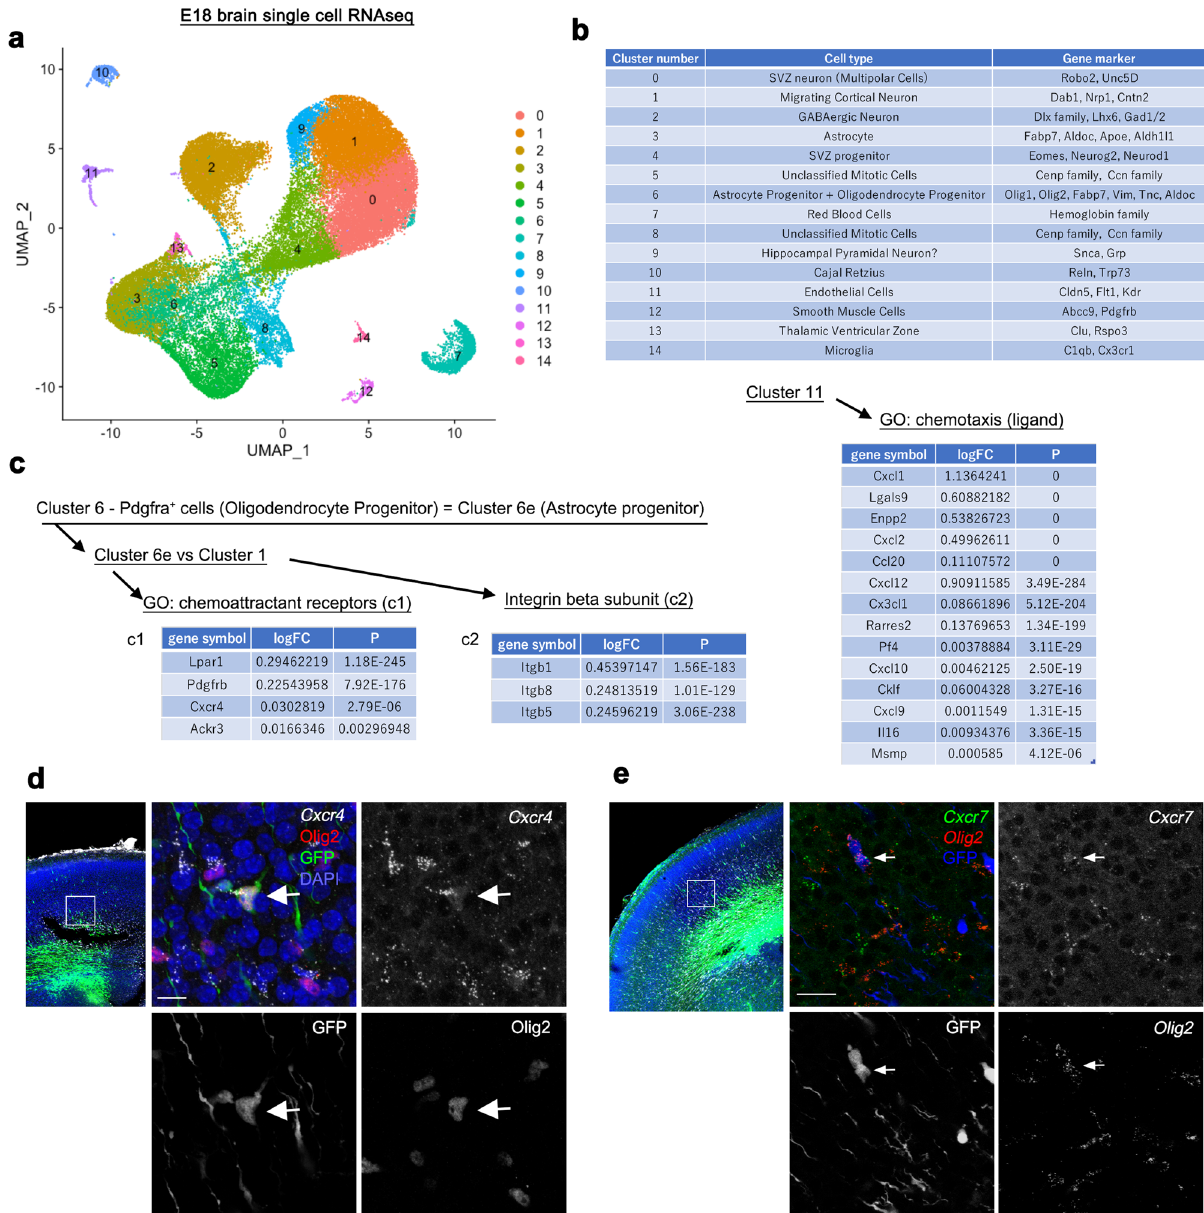
Fig. 5 | Identi fi cation of Cxcr4 and Cxcr7 (Ackr3) and Integrin β 1 as candidate molecules that regulate the blood vessel-guided migration. a UMAP (uniform manifold approximation and projection) visualization of approximately 50,000singlecellRNA-seqdatarandomlysampledfromthefulldataset(1.3million cells) of E18 mouse whole brains. 15 clusters were identi fi ed. b Annotation of cell types for the 15 clusters based on gene markers as indicated. Clusters 1, 6 and 11 represent migrating cortical neurons, glial progenitors (astrocyte progenitors and oligodendrocyte progenitors), and endothelial cells, respectively. c Identi fi cation of astrocyte-speci fi c chemoattractant receptors (c1) and their candidate ligands secreted from endothelial cells (right). We identi fi ed Cxcr4 and Cxcr7 (Ackr3), which are receptors for Cxcl12 secreted from endothelial cells, as candidate molecules that regulate the blood vessel-guided migration. We also identi fi ed